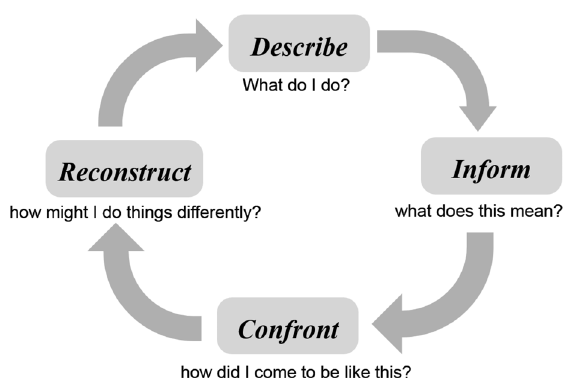
Figure 1. Smyth’s 11 reflective